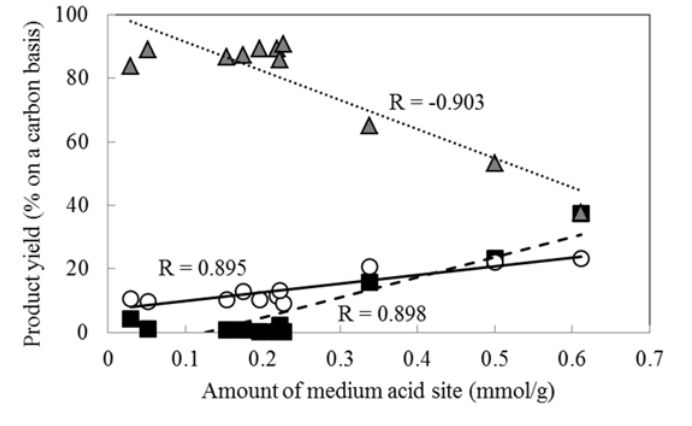
Figure 1. Relationship between acid amount and product yield in the hydrocracking reaction over Pt-loaded catalysts. Entries 1–7 and 13–16 in Table 4, Pt content: 0.1 wt.